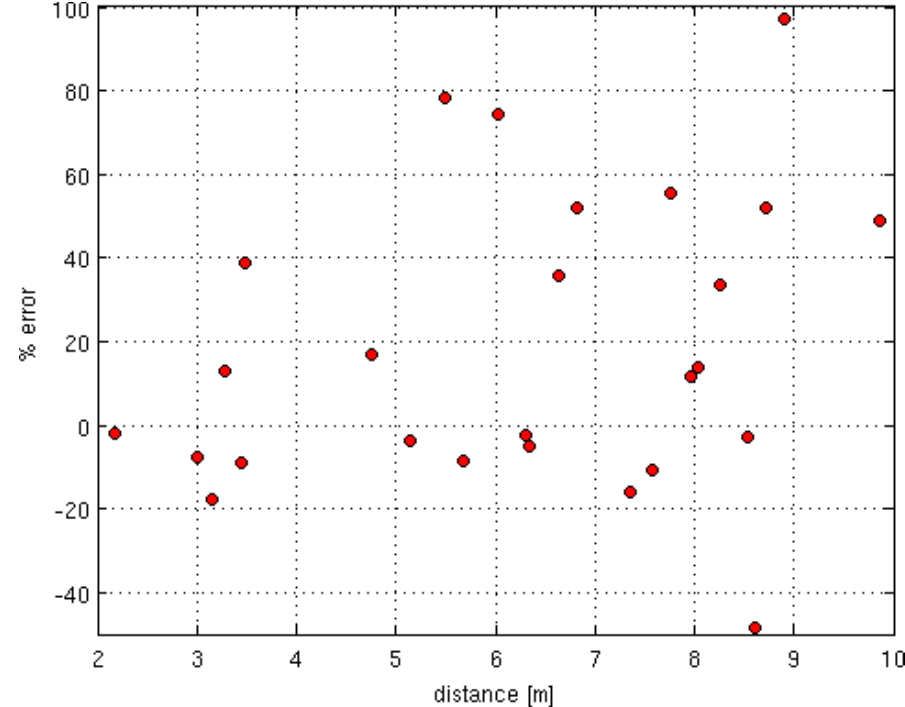
Figure 15. Error vs. distance to tree for Plots 165, 167 and 343. The errors increase slightly with distance.